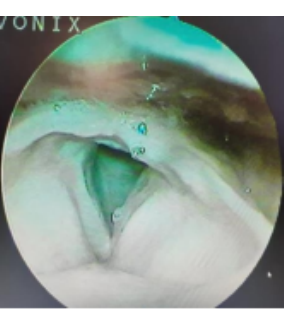
Figure 2. Left vocal polyp